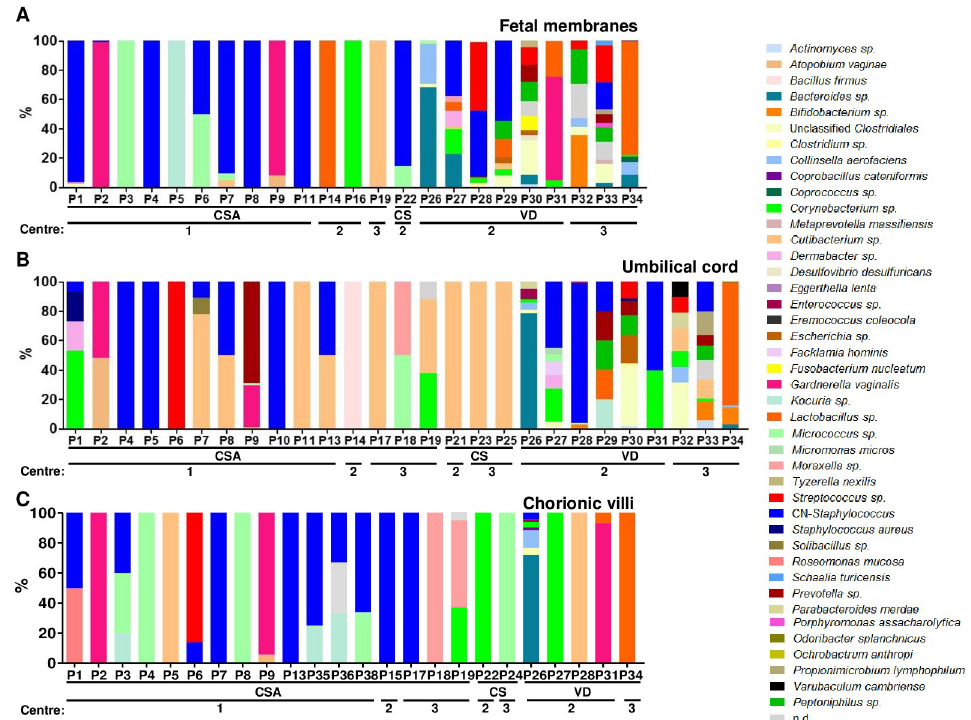
Fig 2. Prevalence (%) of each bacterial species/genus in fetal membranes (A), umbilical cords (B) and chorionic villi (C). Samples that did not harbor any bacteria were removed. The higher diversity was observed in external samples (fetal membranes and umbilical cords) coming from vaginal delivery. CSA: cesarean section with Alexis 1 ; CS: cesarean section; VD: vaginal delivery; Centre 1: Port Royal maternity; Centre 2: Antoine Be´cl è re Hospital maternity; Centre 3: Sainte Fe´licite´